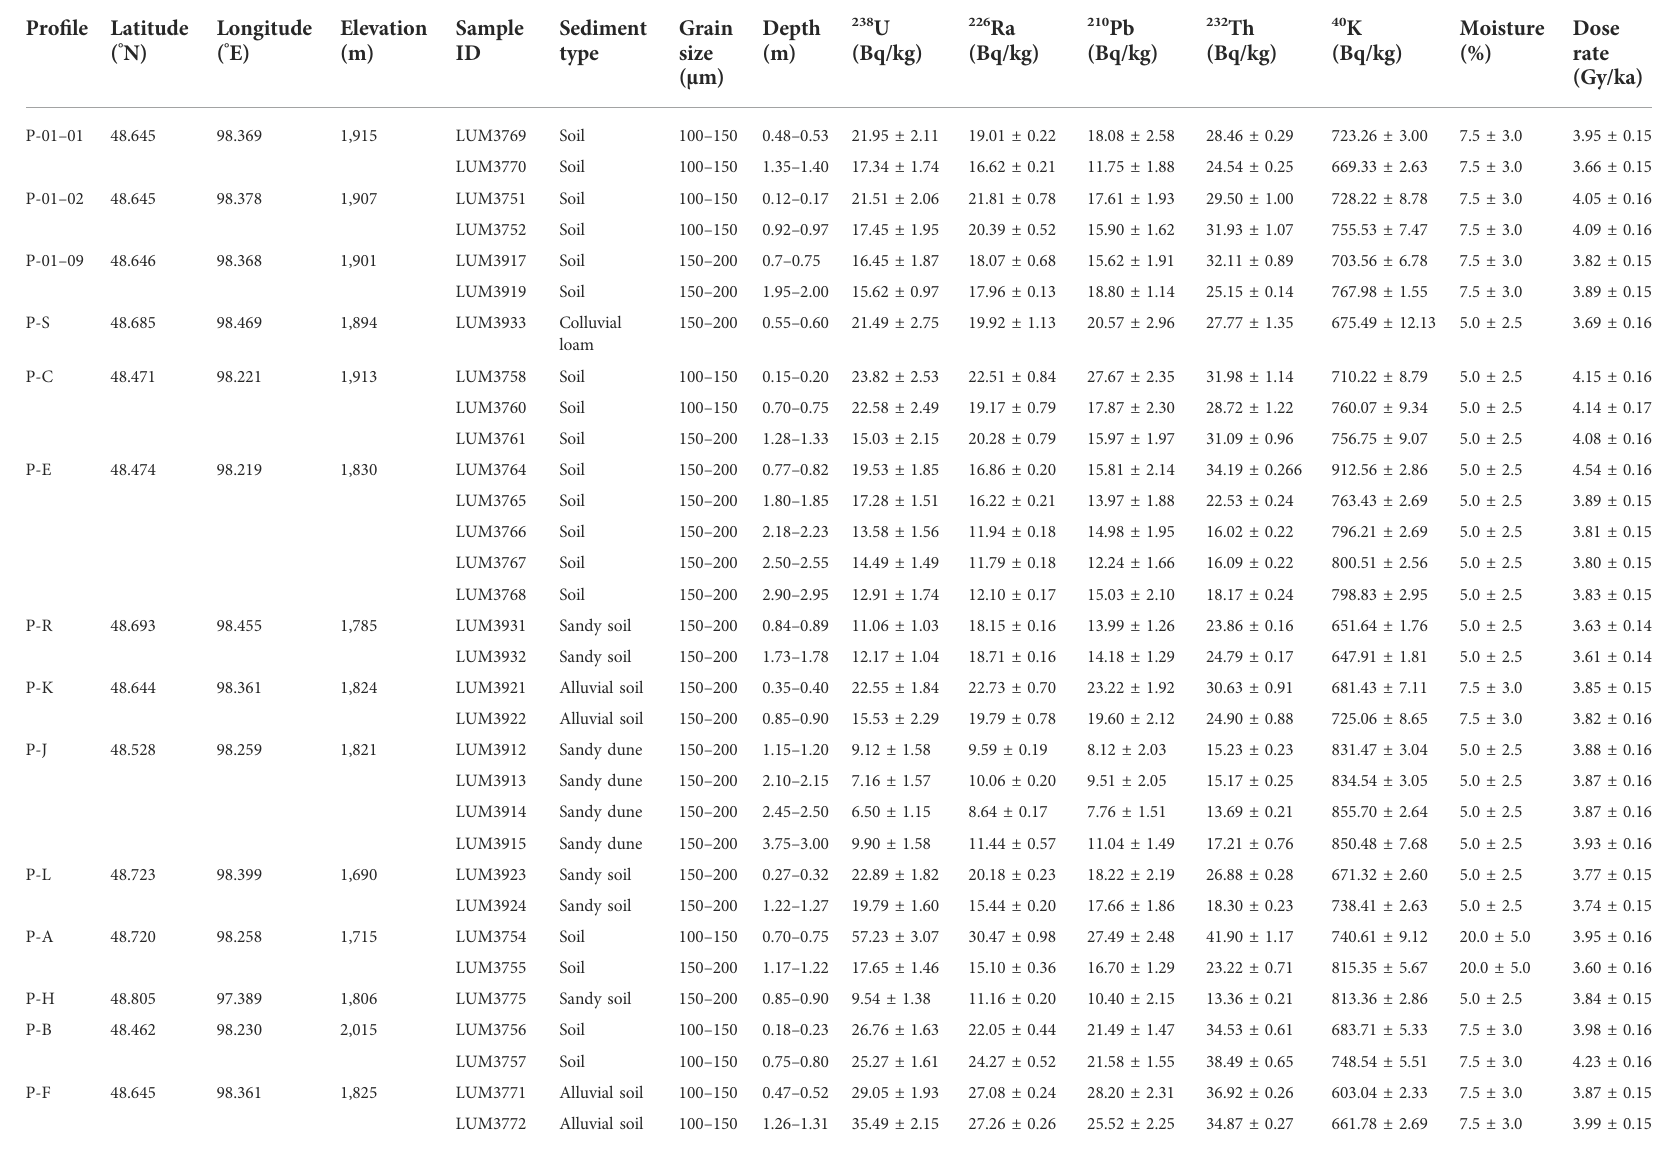
TABLE 1 Sample information and dose rate